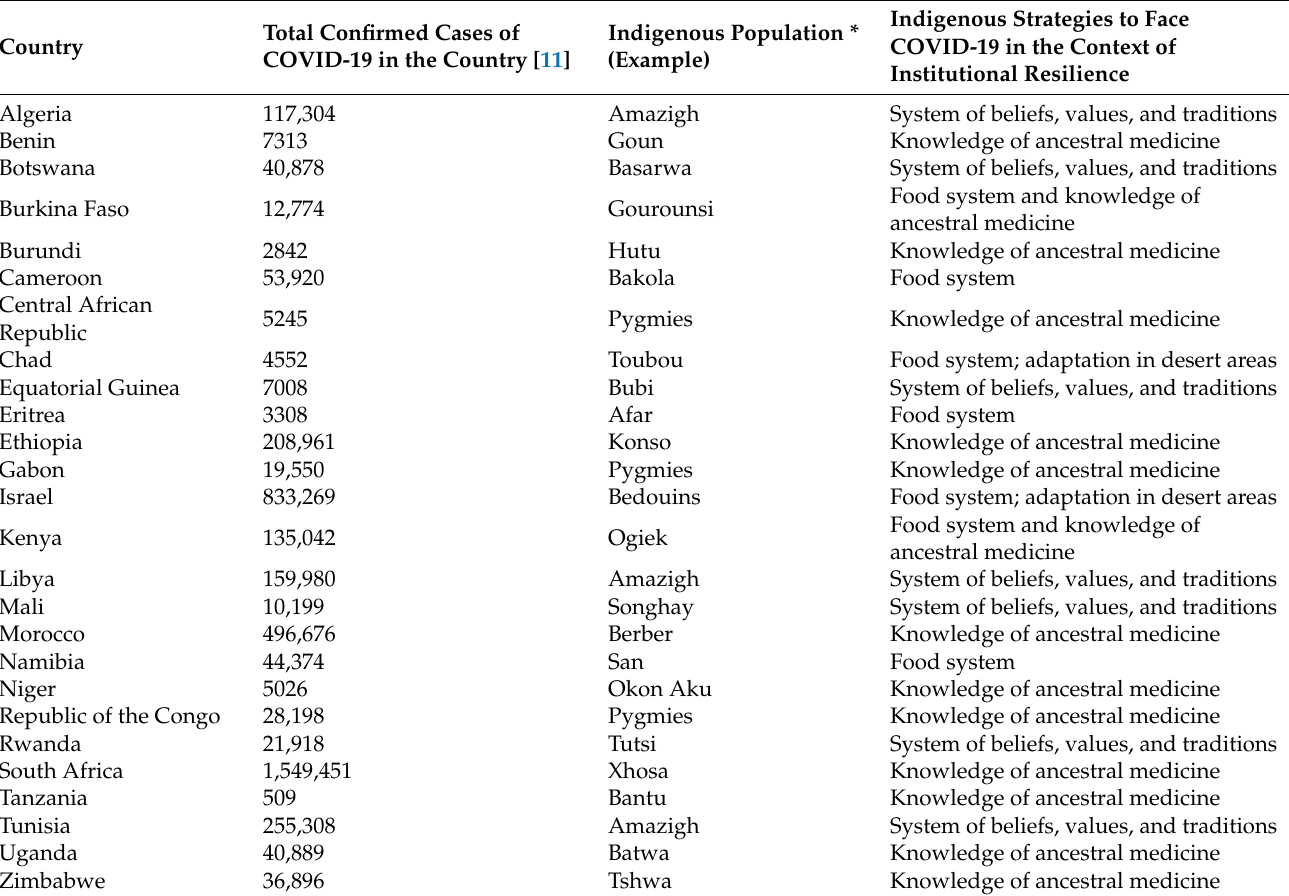
Table 2. African countries with indigenous populations and their strategies deployed in the face of COVID-19.